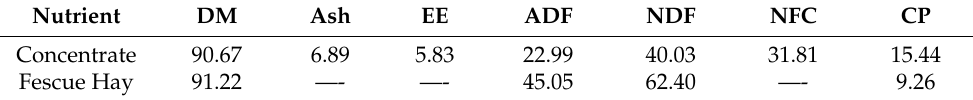
Table 1. Chemical composition (%) of concentrate (Easy Keeper Edge, MFA) and fescue hay. Nutrient